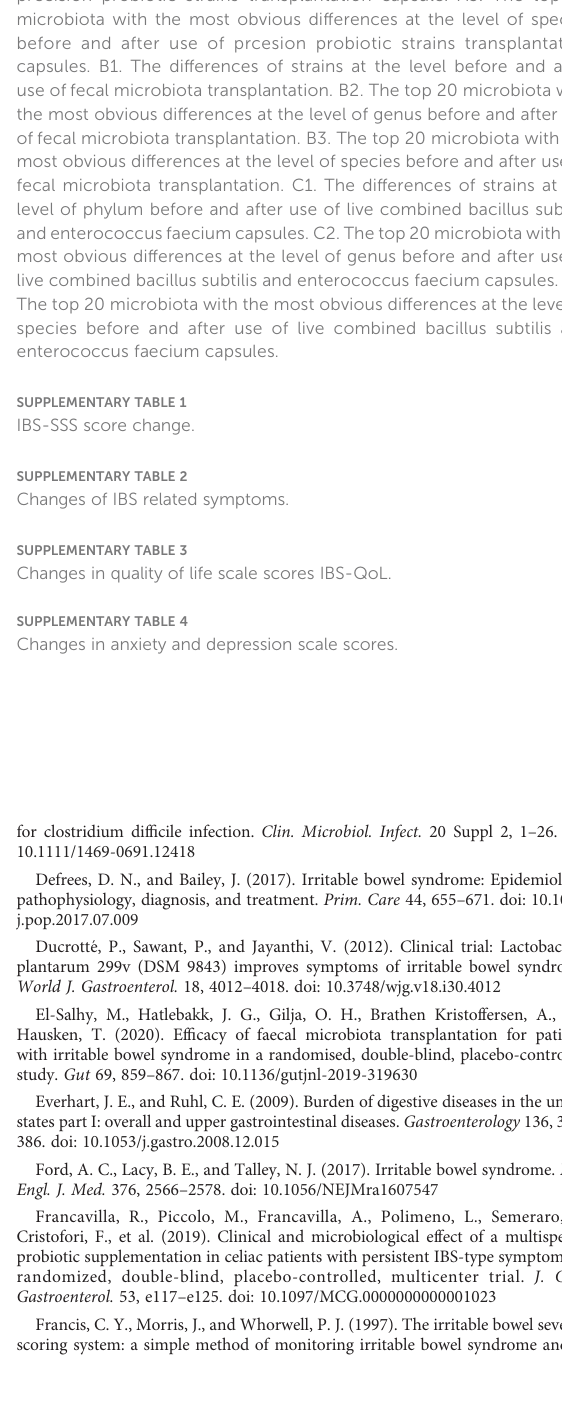
SUPPLEMENTARY TABLE 1 IBS-SSS score change.